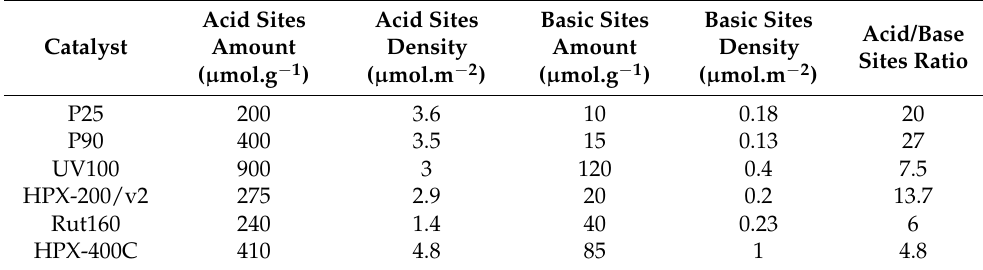
Table 2. Catalysts’ acid/basic sites amounts and